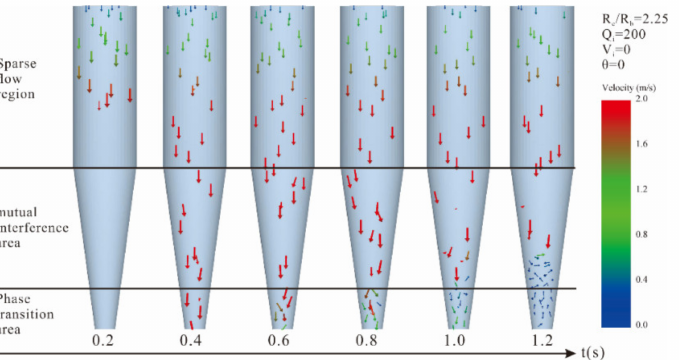
Figure 5. The mean velocity vector profile of the bridging ball during the MBP